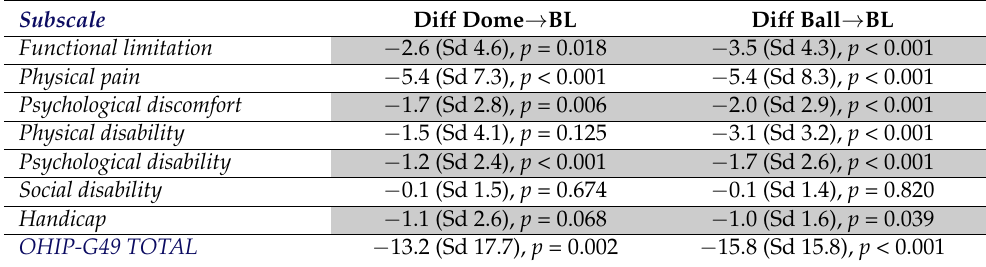
Table 2. Difference (Diff) of dome and ball attachments vs. baseline (BL).